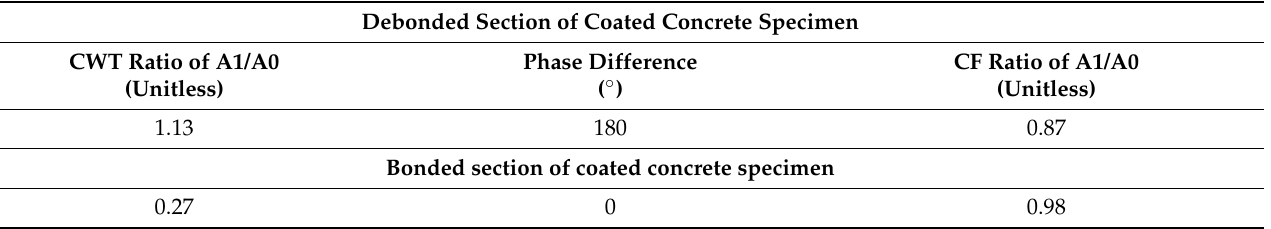
Table 3. Waveform unitless parameters obtained from CWT and Hilbert